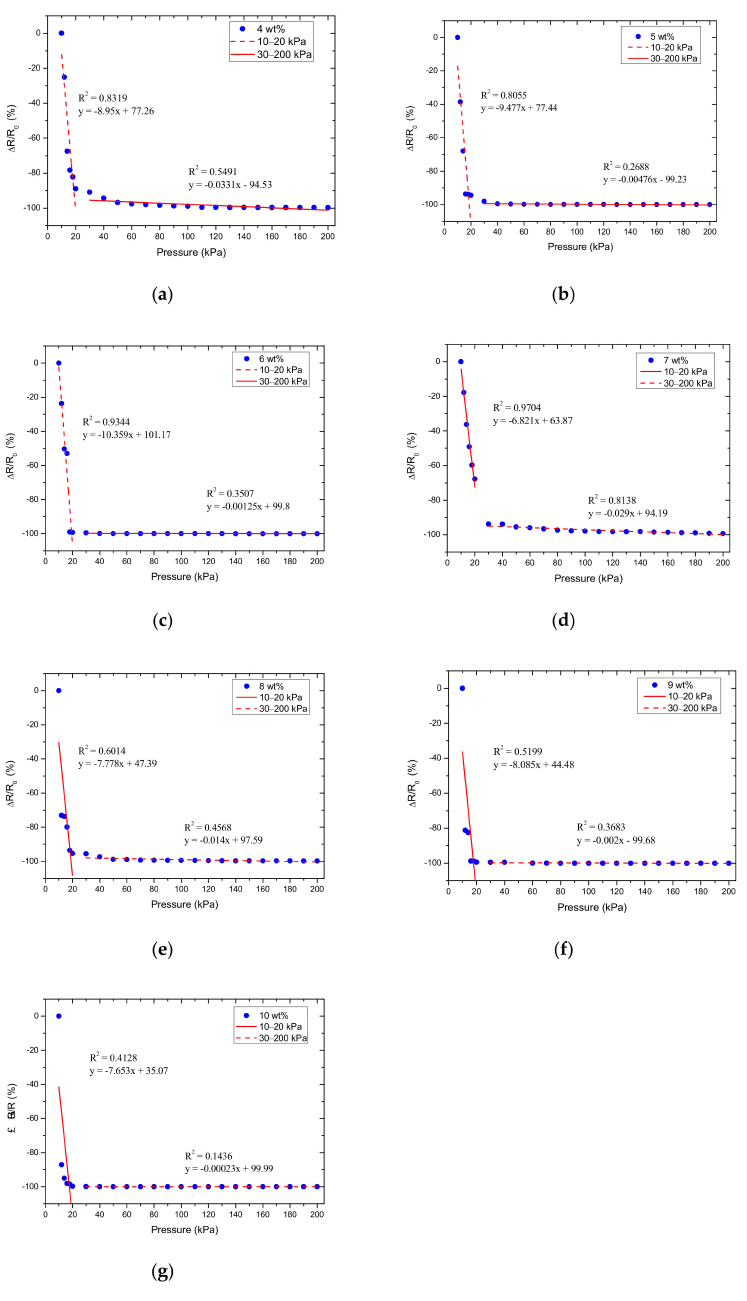
Figure 13. The relative resistance change as a function of applied pressure for MWCNT doping ratios of ( a ) 4 wt.%, ( b ) 5 wt.%, ( c ) 6 wt.%, ( d ) 7 wt.%, ( e ) 8 wt.%, ( f ) 9 wt.%, and ( g ) 10